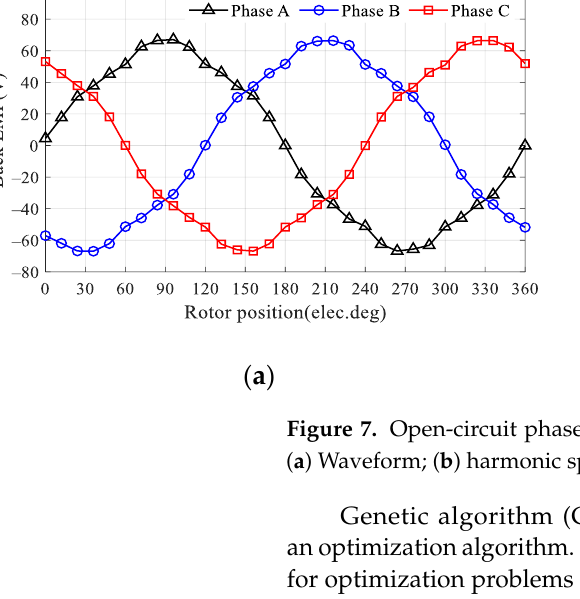
Table 3. Range of design parameters of the AF-FMPM machine.